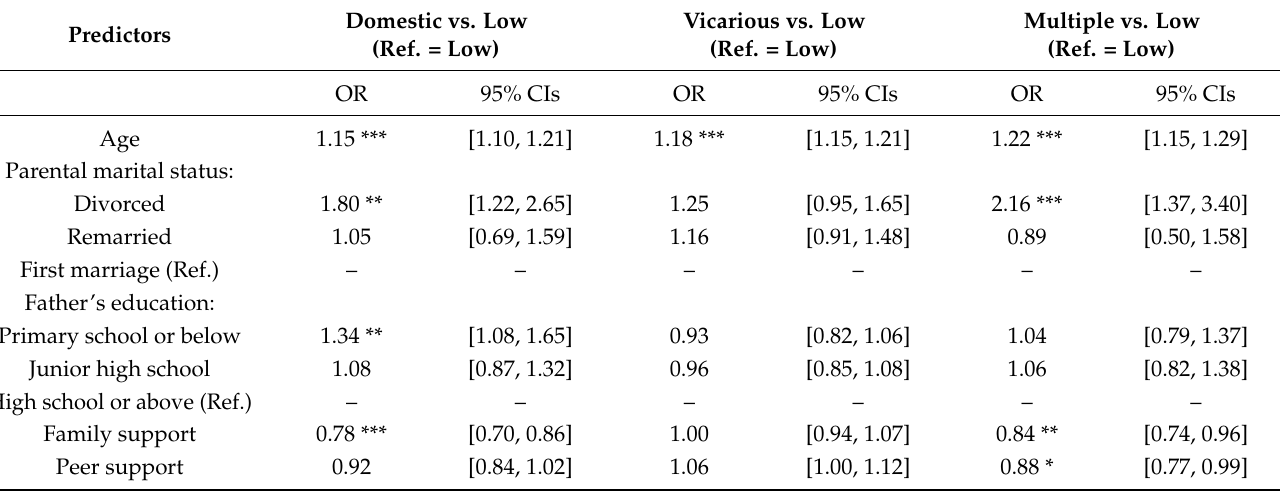
Table 5. Multinomial logistic regressions for predictors of CTE class membership of males ( N =